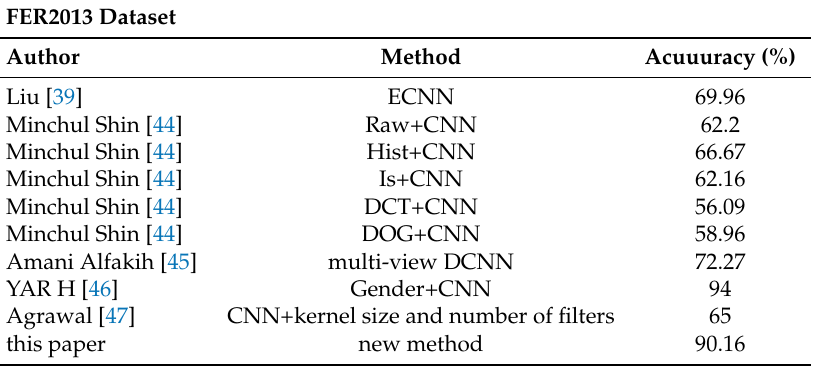
Table 6. This table summarises the current state of the art in facial expression recognition on FER2013